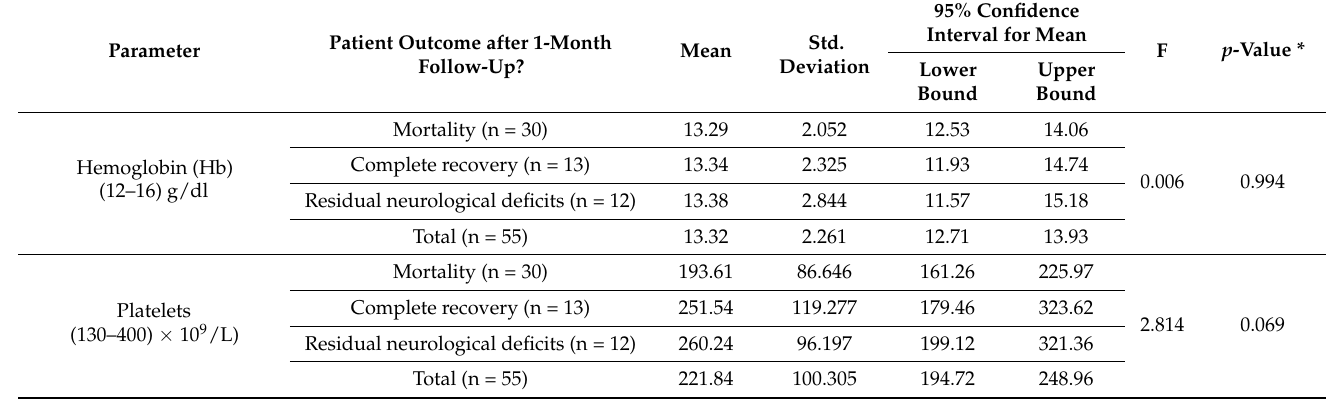
Table 3. Relation of laboratory parameters with the patient outcome by using